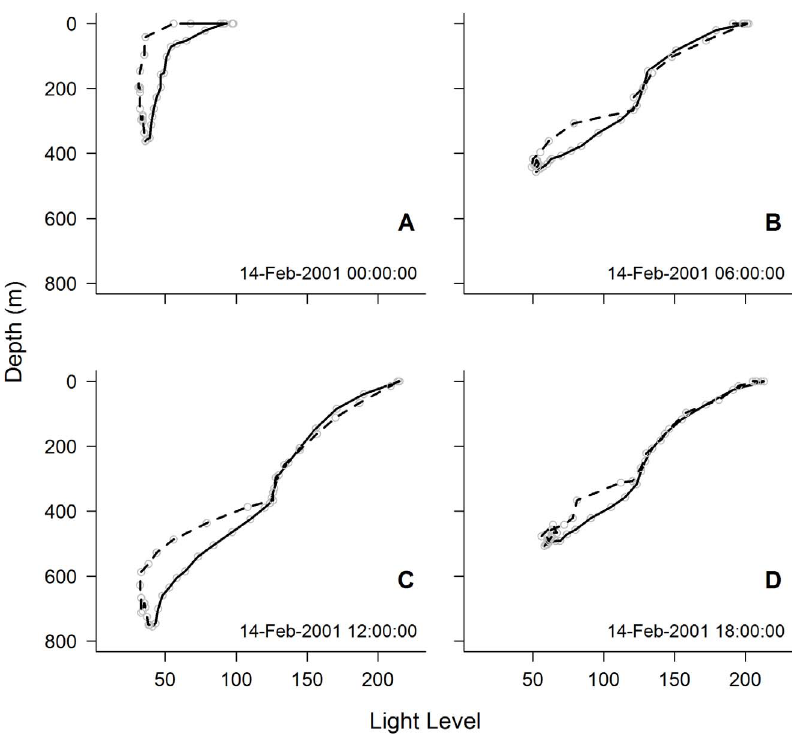
Figure 1. Examples of light-depth profiles collected from the descent (solid) and ascent (dashed) phases of dives. Profiles recorded at local (A) midnight, (B) 6am, (C) noon and (D) 6pm on 14 February 2001. Light level values are related to blue light intensity (W cm 2 2 ). Calibrations are